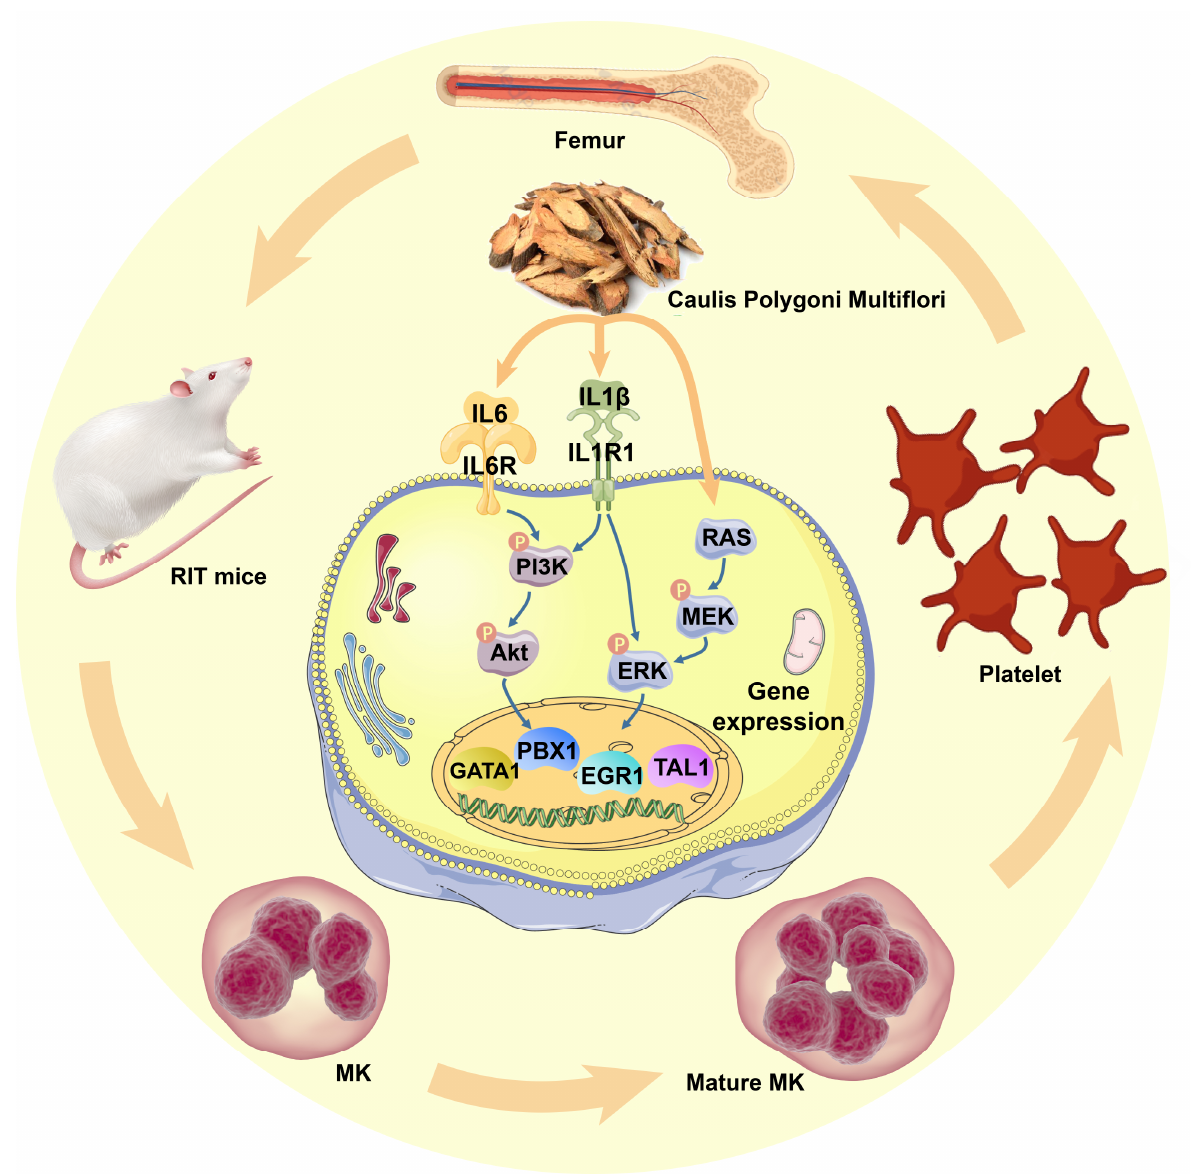
Figure 7. Schematic model for CPM action in regulating megakaryopoiesis and thrombopoiesis. CPM induces IL-6 and IL1R1 expressions, causing the activation of PI3K/Akt and MEK/ERK (MAPK) signaling pathways, followed by the activation of downstream hematopoietic TFs, includ- ing GATA1, TAL1, PBX1 and EGR1, which stimulate MK differentiation and platelet production. TAL1, PBX1 and EGR1, which stimulate MK differentiation and platelet